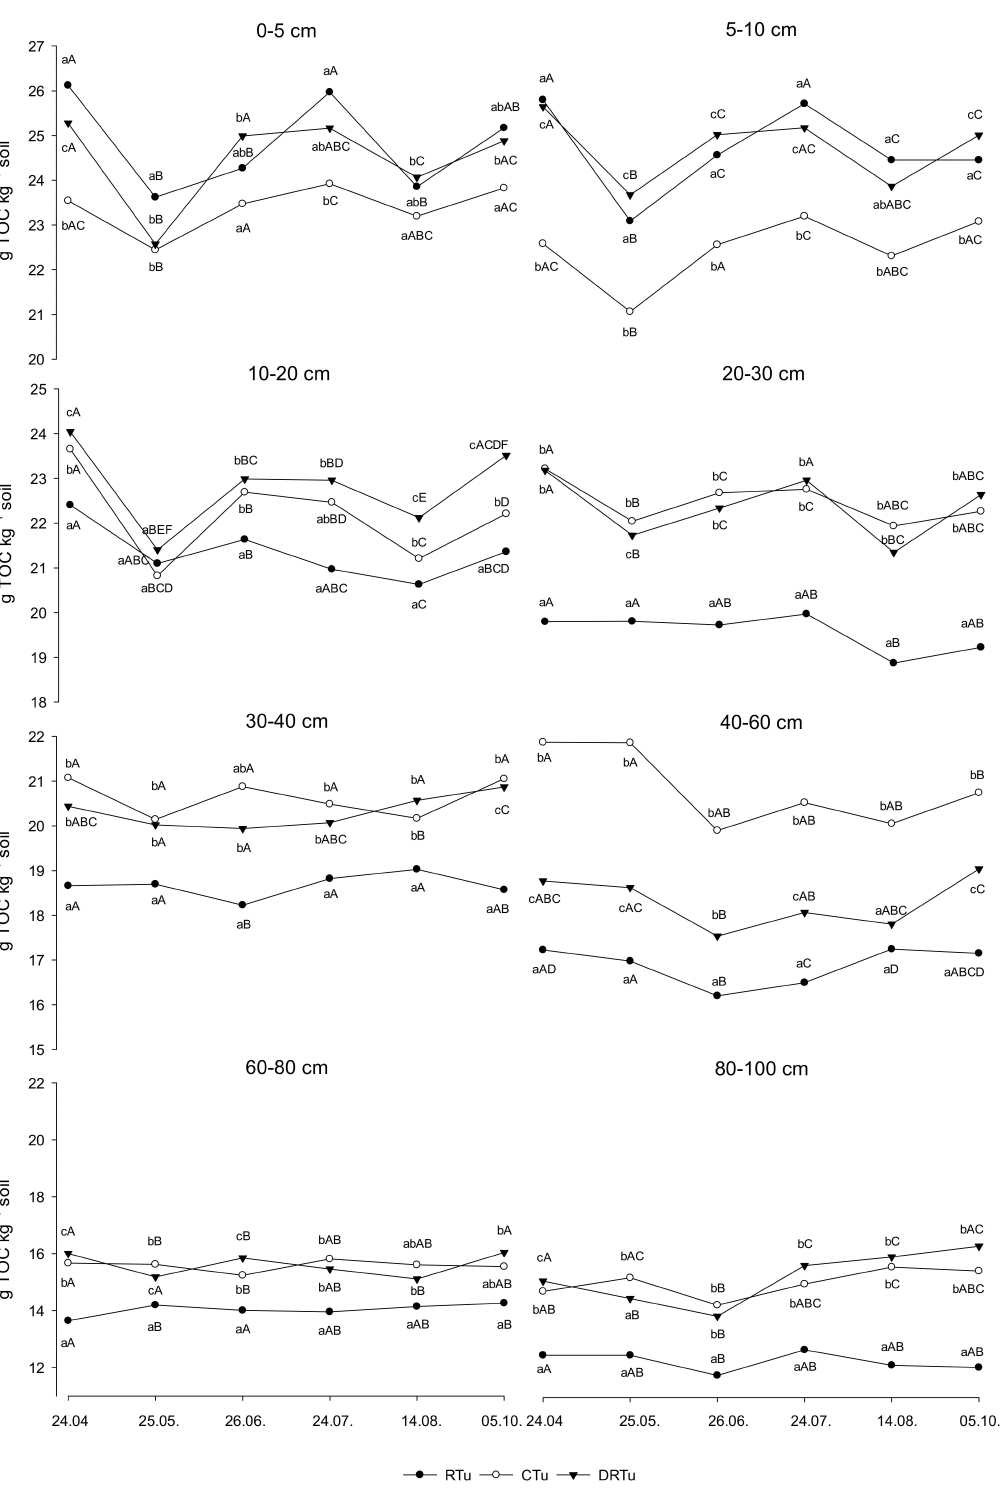
Figure 3. TOC content changes in the 0–5, 5–10, 10–20, 20–30, 30–40, 40–60, 60–80 and 80–100 cm layers across the growing season under 14 years of continuous application: reduced tillage (RTu), conventional tillage (Ctu) and deep reduced tillage (DRTu). The plant was barley. Mean values by different lowercase letters demarcate a significant difference among different tillage adjustments within the same sampling time (significant differences a = 0.05). Mean values by different capital letters demarcate a significant difference among different sampling periods (significant differences a =